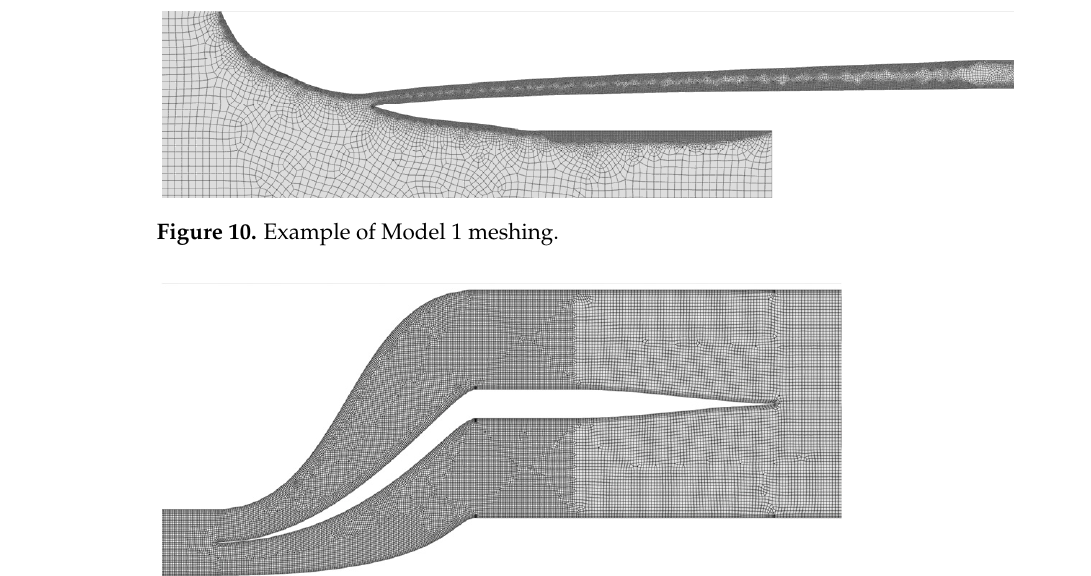
Figure 9. Model 1 grid convergence study.